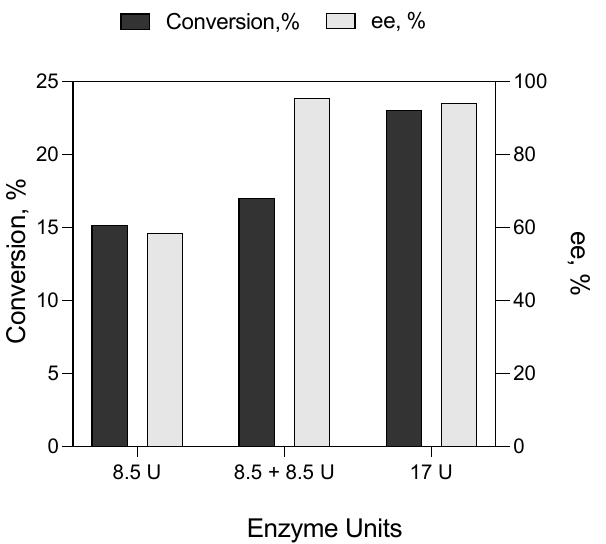
Figure 5. Hydrolysis of racemic ibuprofen methyl ester to S -ibuprofen. Reaction time, 24 h; temper- ature, 65 °C; cosolvent 10% ( v / v ) DMF. Different units of KLEST-3S and addition modes (one step or two). Table 3. Hydrolysis of ibuprofen methyl ester to S -ibuprofen with KLEST-3S varying Tween 20 amounts. Enzyme units, 15. Cosolvent, 10% ( v / v ) DMF. Temperature 47 ◦ C; time, 24